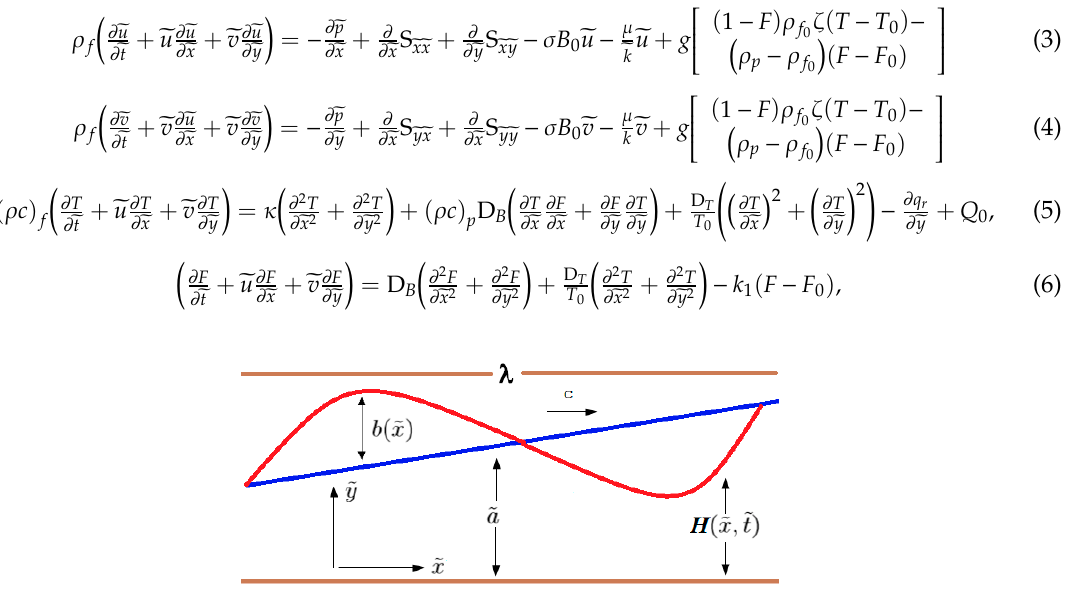
Figure 1. The geometry of the problem.